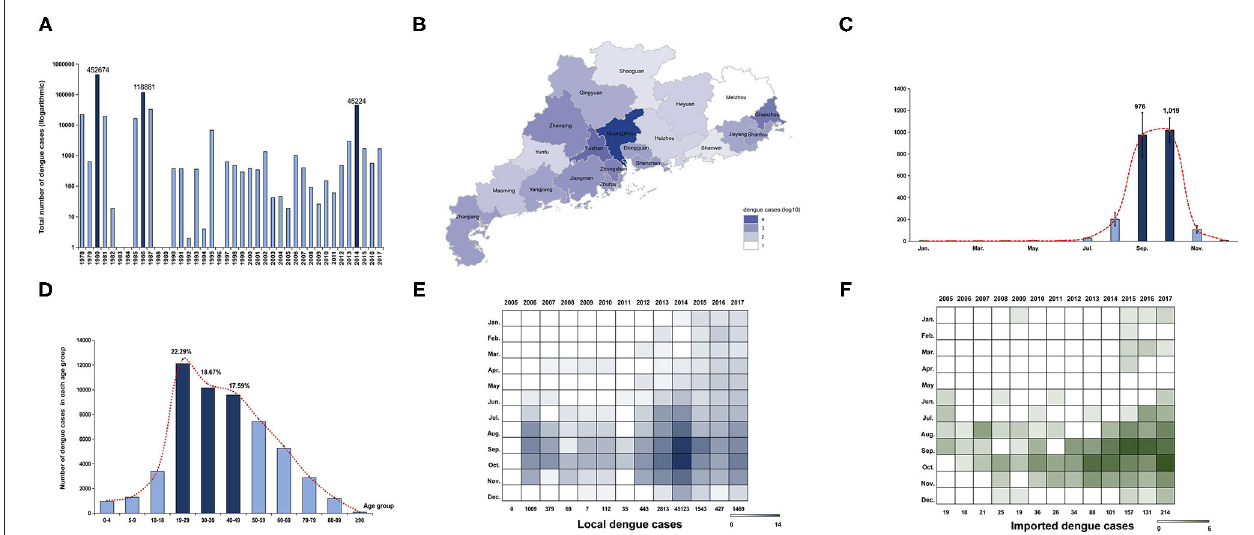
FIGURE 1 | Epidemiology characteristics of dengue in Guangdong from 1978 to 2017. (A) Annual number of dengue cases in Guangdong from 1978 to 2017. The Y axis is displayed on the logarithmic scale (log10). Three major dengue epidemics are marked by dark blue. (B) Geographic distribution of accumulated dengue cases from 1990 to 2017 in 21 cities of Guangdong. The number of dengue cases in each city is displayed by colors of shades according to logarithmic form (log10). (C) Seasonal distribution of dengue in Guangdong from 1990 to 2017. The number of cases in each month is presented by the average number within the last 28 years. The incidence peak is shaded according to logarithmic scale (log10). (D) The age distribution is presented by accumulated dengue cases from 2005 to 2017 in each age group. The more affected groups are marked by dark blue. (E,F) The number of local and imported cases each month is shaded according to the logarithmic scale